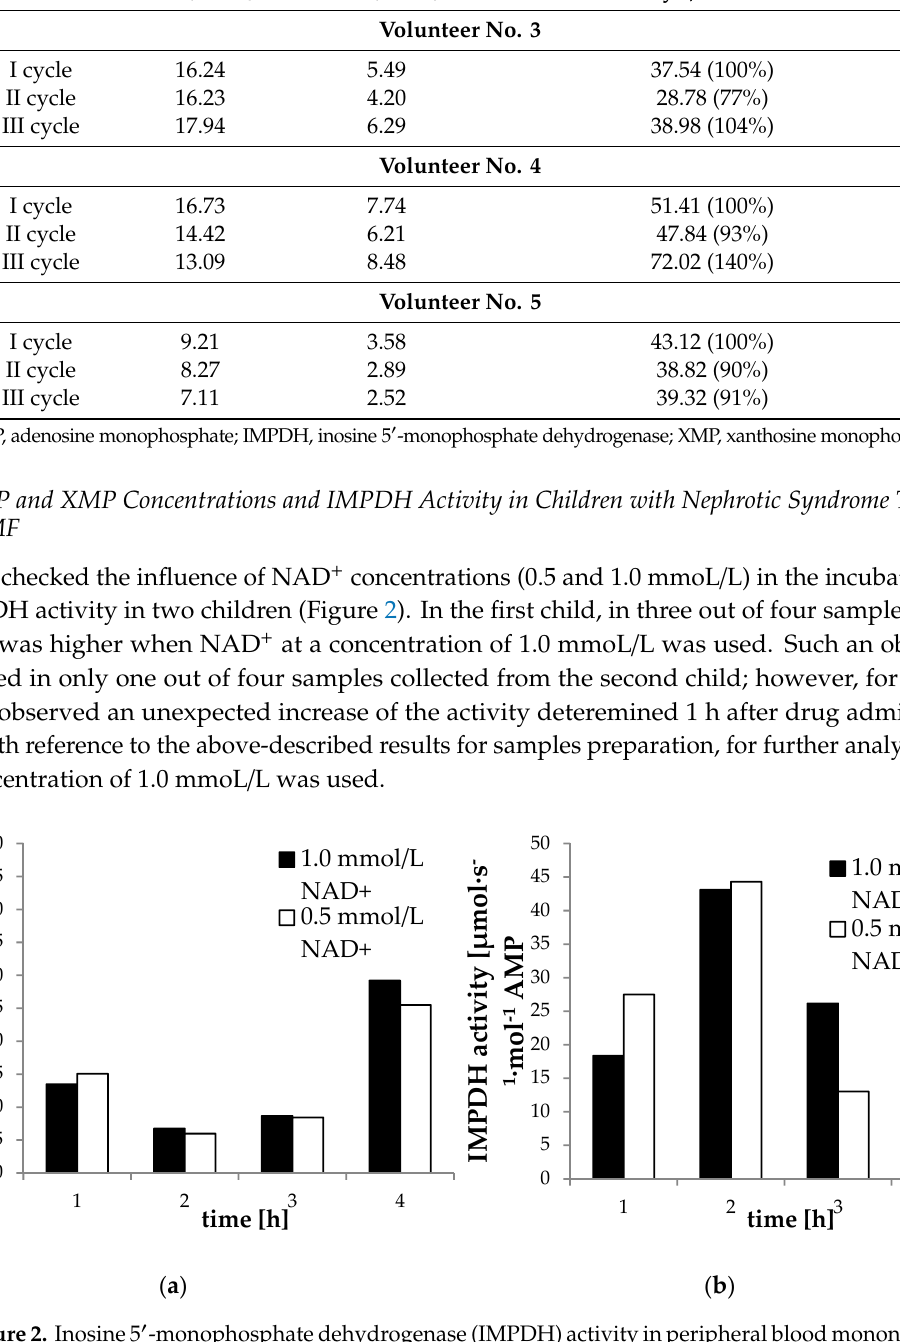
Figure 2. Inosine 5 (cid:48) -monophosphate dehydrogenase (IMPDH) activity in peripheral blood mononuclear cells (PBMCs) from child No. 2 ( a ) and No. 5 ( b ) after incubation with nicotinamide adenine dinucleotide (NAD + ) at a concentration of 0.5 mmoL / L (white bar) and 1.0 mmoL / L (black